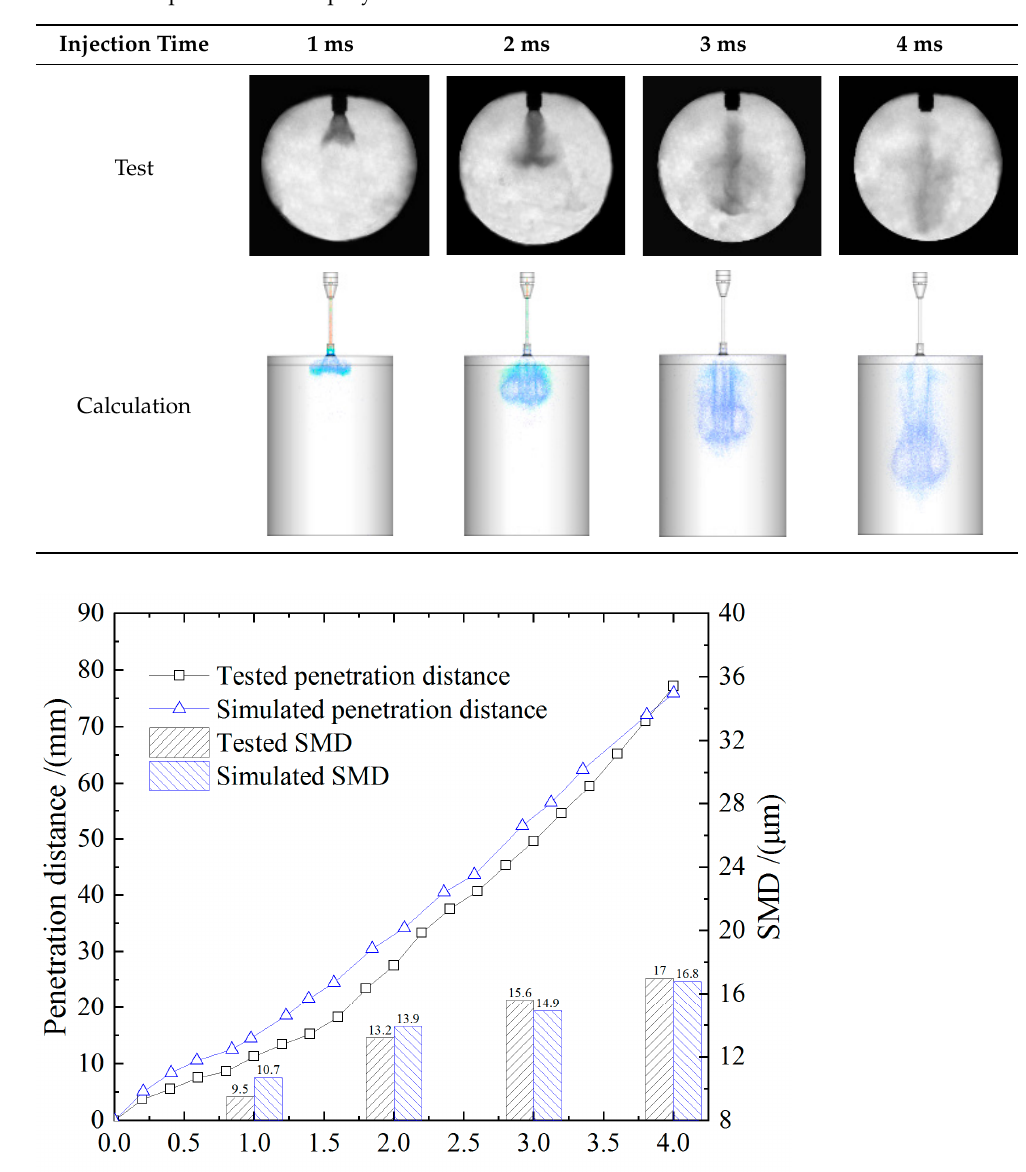
Table 1. Comparison of fuel spray tests and calculation results.